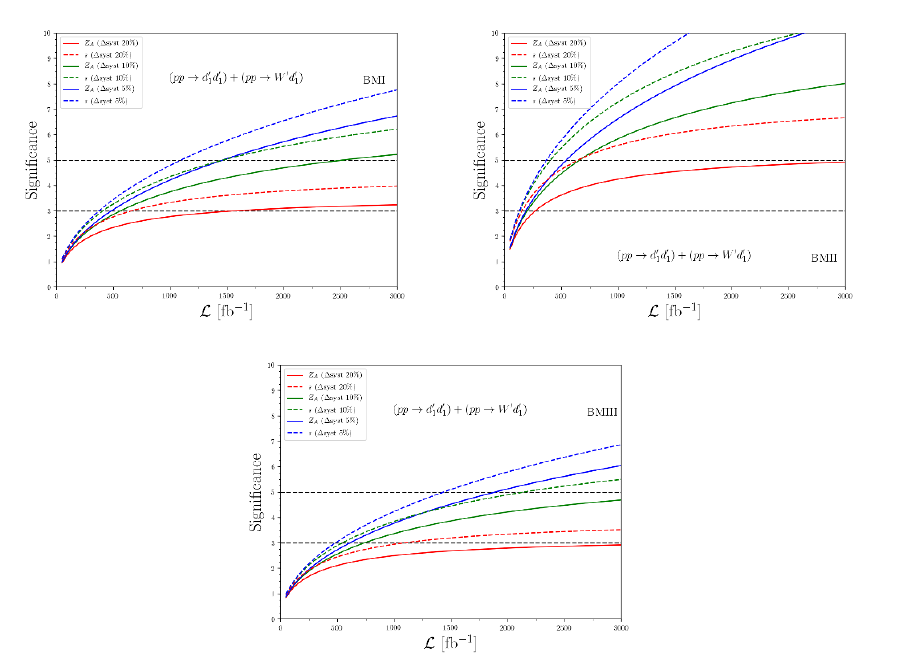
Figure 5 . LHC sensitivity to a signature comprised of a dilepton, jets and missing energy in the context of the BM I (upper left), BM II (upper right) and BM III (lower) scenarios. We present our results as a function of the luminosity and recast the CMS stop search of ref. [88], and plot the two signi(cid:12)cance measures of eq.